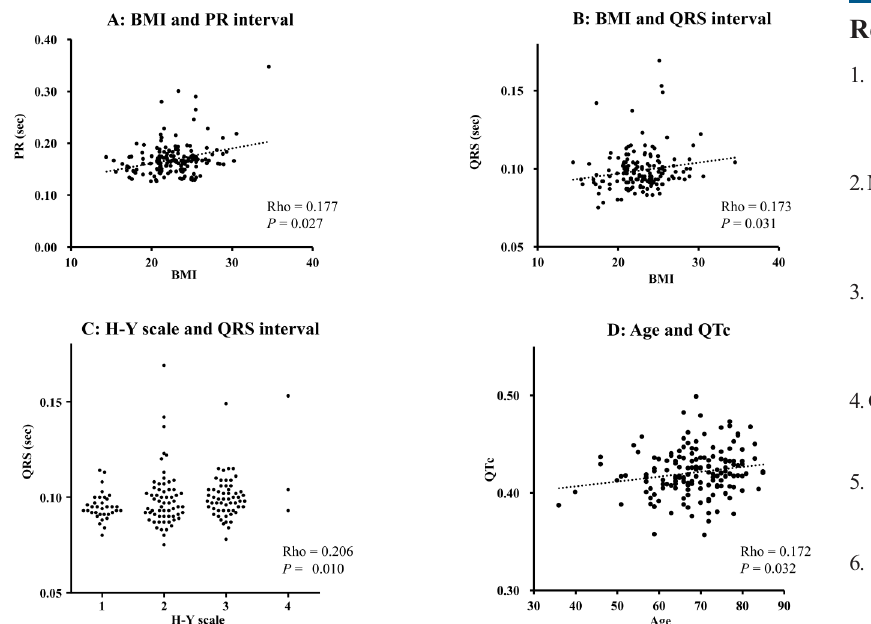
Figure 1. Scatter diagrams showing the relationship between clinical features and electro- cardiogram parameters. Body mass index was positively correlated with PR (A) and QRS (B) intervals. QRS interval was positively correlated with Hoehn and Yahr (C) stage, and QTc was positively correlated with age study, mortality in 10 out of 131 PD patients (7.6%) was due to sudden death. 11 Prolongation of the QTc interval increases the risk of sudden cardiac death. 12 To decrease this risk, attention should be paid ment of elderly PD patients.